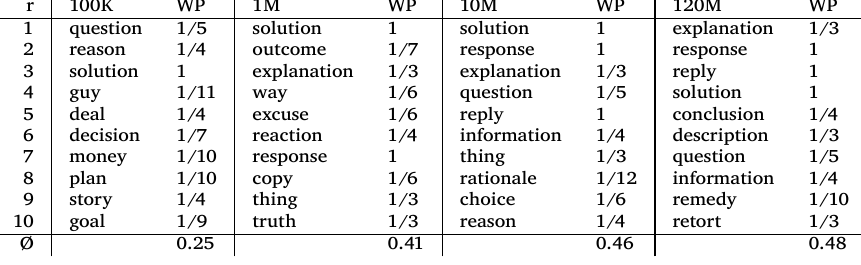
Figure 5: DT entries for “answer” with WordNet path similarities (WP), compar- ing different corpus sizes from 100K sentences up to 120M sentences Target: tint